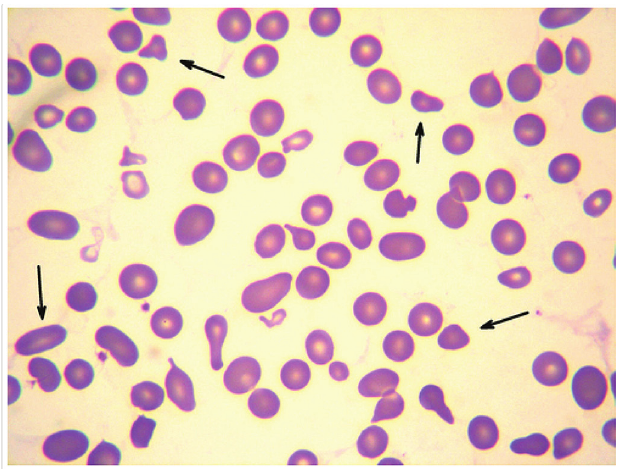
figurE 1 − Peripheral blood smear showing presence of schistocytes (400×)